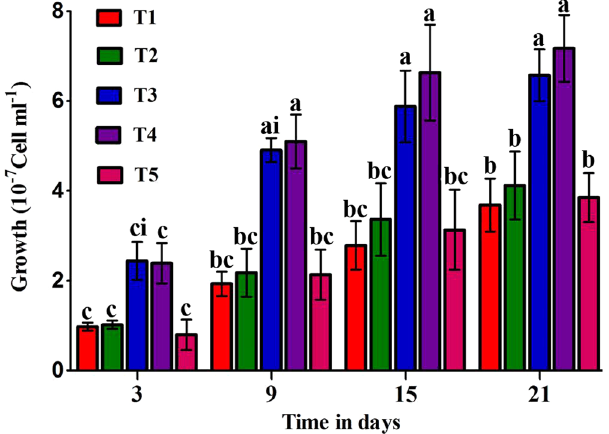
Figure 1. Cell density of D. salina cells grown over 21 d, with five treatments (T1 to T5) respectively at 0.5, 1, 1.5, 2.0, and 2.5 M NaCl. The analysis was done by two-way ANOVA considering Bonferroni post-tests to compare the means of the replicates at P < 0.05. Those labeled with different letters are significantly